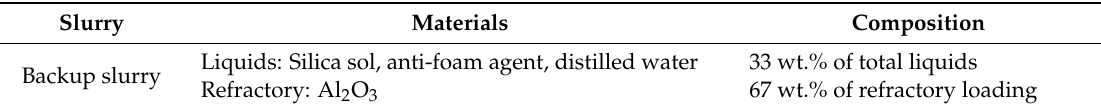
Table 2. Backup slurry composition for ceramic